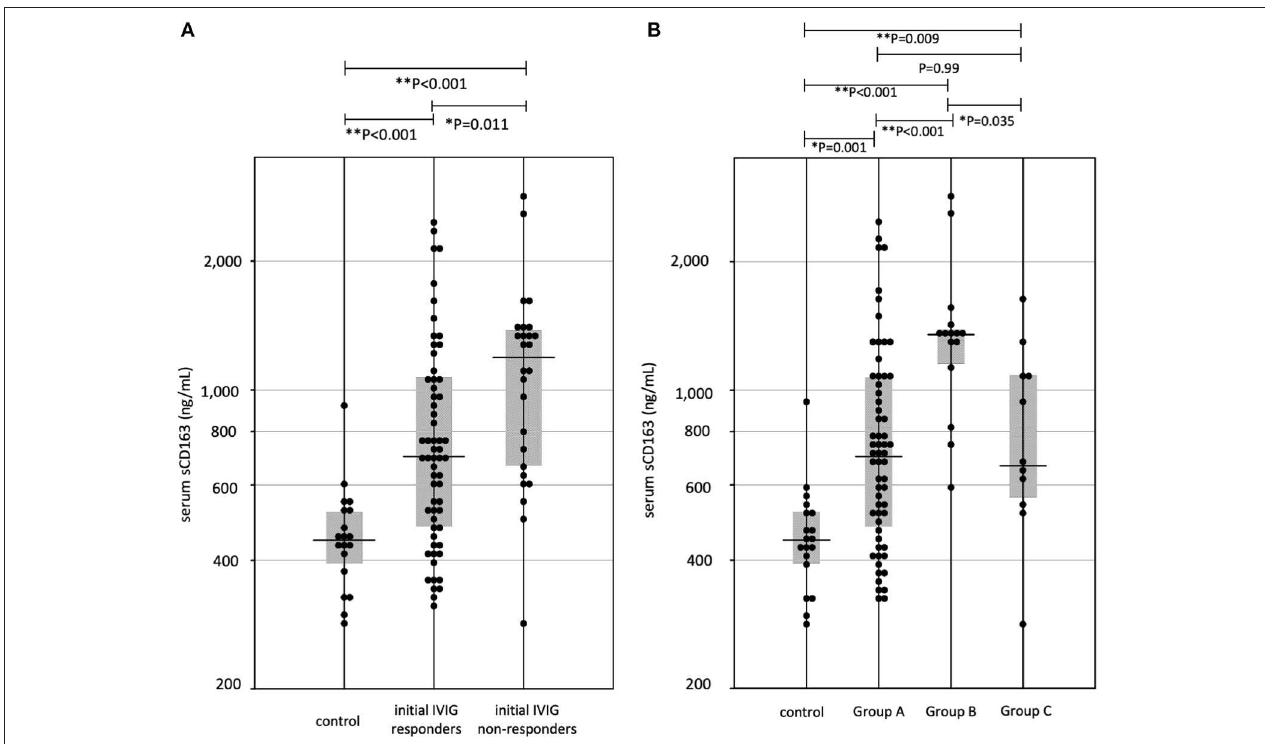
FIGURE 2 | (A) The sCD163 levels in Kawasaki disease (KD). IVIG, intravenous immunoglobulin, * P < 0.05, ** P < 0.01 (B) The relationship three groups divided for effective therapies and sCD163 levels. Group A, initial IVIG responders; Group B, additional IVIG responders; Group C, patients who require 3rd line therapy, * P < 0.05, ** P <